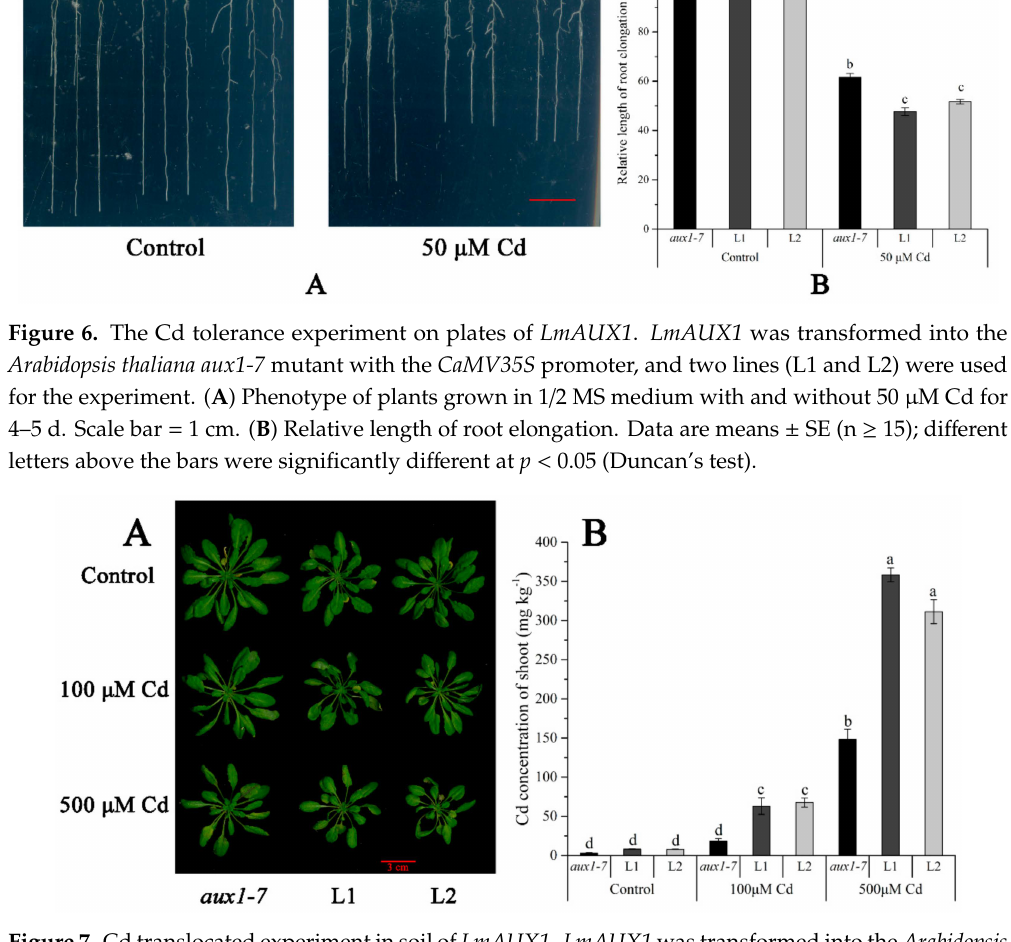
Figure 7. Cd translocated experiment in soil of LmAUX1 . LmAUX1 was transformed into the Arabidopsis thaliana aux1-7 mutant with the CaMV35S promoter, and two lines (L1 and L2) were used for the experiment. ( A ) Phenotype of plants grown in soils irrigated with 0, 100, or 500 µ M Cd solution for 3–4 weeks. ( B ) The Cd concentration of shoot. Data are means ± SE (n = 3); di ff erent letters above the bars are significantly di ff erent at p < 0.05 (Duncan’s